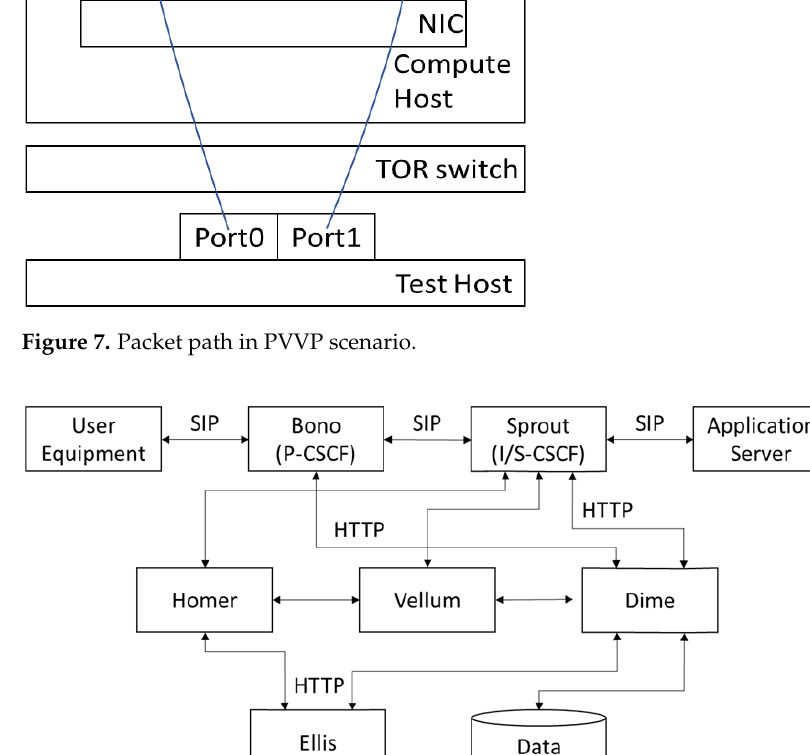
Figure 8. Architecture of Clearwater vIMS.